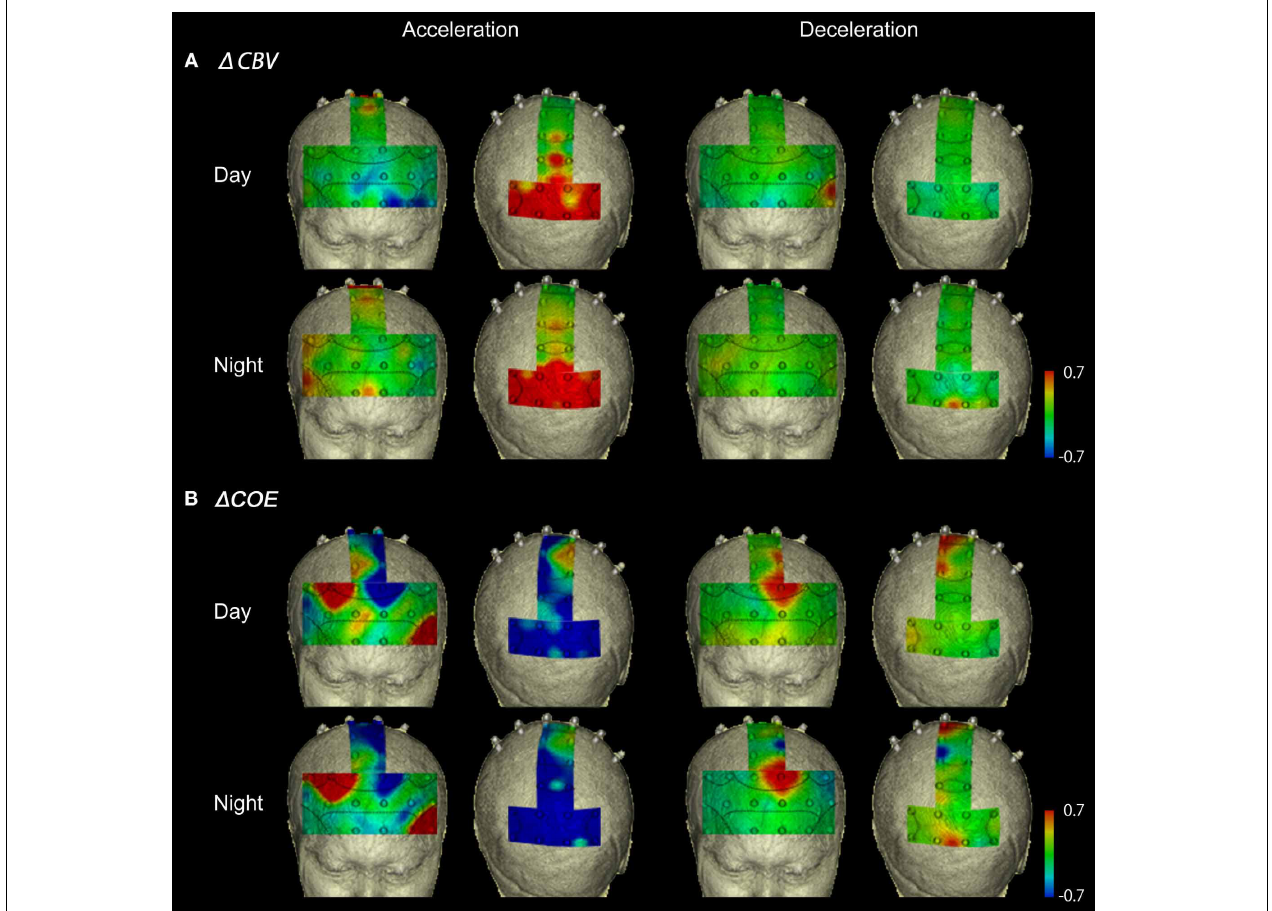
FIGURE 6 | Functional neuroimages of (cid:2) CBV and (cid:2) COE from actual driving, during acceleration and deceleration. Functional imaging of (cid:2) CBV (A) and (cid:2) COE (B) from the prefrontal cortex (Ch 1-27), the motor-related